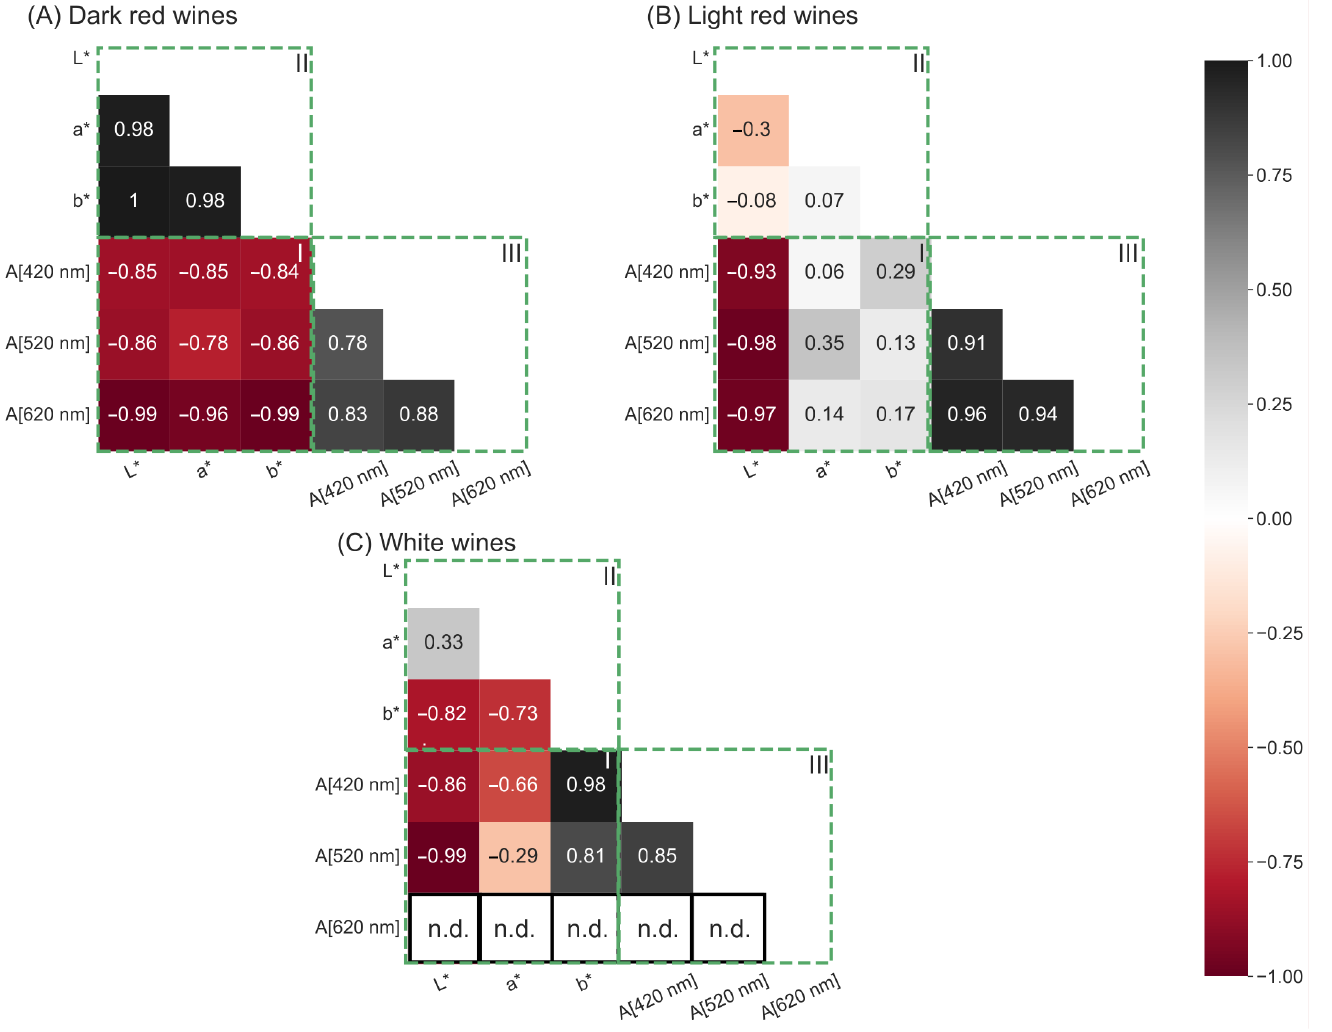
Figure 6. Correlation matrices depicting the Spearman coefficients for dark red wine (( A ), n = 34), light red wine (( B ), n = 22), and white wine (( C ), n = 56). Evaluated were the correlations between CIE L*a*b* coordinates and Glories absorbance values at wavelengths 420 nm, 520 nm and 620 nm (A[420 nm], A[520 nm], A[620 nm]) (I), between L*, a*, and b* coordinates (II), and between Glories absorbance values